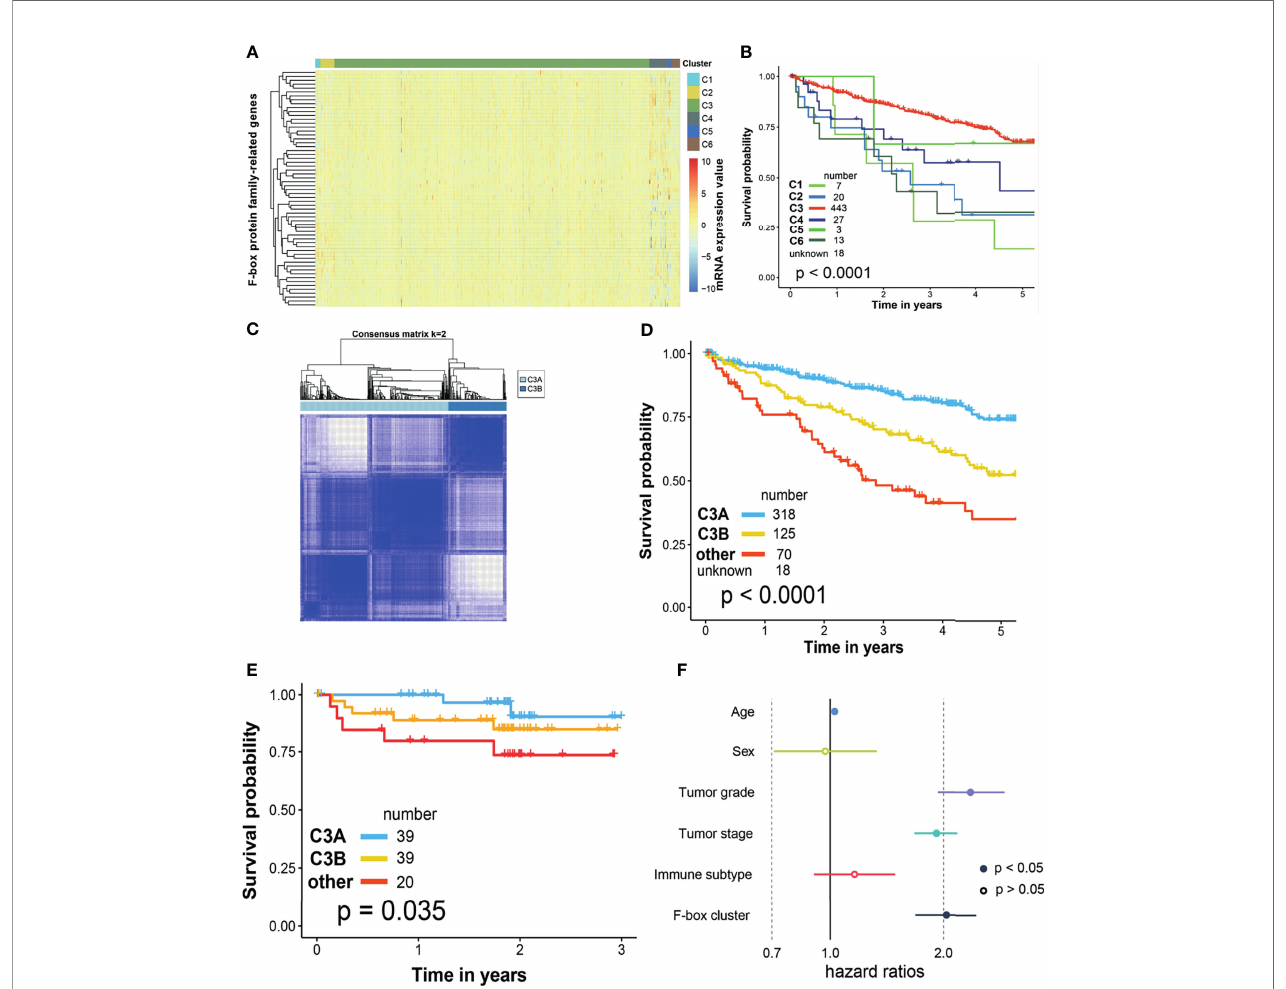
FIGURE 4 | Novel phenotyping of ccRCC based on f-box family genes. Evaluation of the prognosis model in ccRCC. (A) Heatmap illustrated the different expressions of f-box family genes in current immune clusters in the TCGA cohort. (B) Kaplan – Meier survival analysis of overall survival strati fi ed by current immune clusters FB-risk for pan-cancer patients in the TCGA cohort. (C) Unsupervised cluster analysis by k-means based on f-box family genes in the TCGA cohort. (D) Kaplan – Meier survival analysis of overall survival strati fi ed by the novel phenotyping in the TCGA cohort. (E) Veri fi cation of risk strati fi cation performance by the novel phenotyping in the CPTAC cohort. (F) Cox regression analysis of the novel phenotyping based on f-box cluster for ccRCC. ccRCC, clear cell renal cell carcinoma; TCGA, The Cancer Genome Atlas; CPTAC, clinical proteomic tumor analysis consortium; FB-risk, f-box family-related